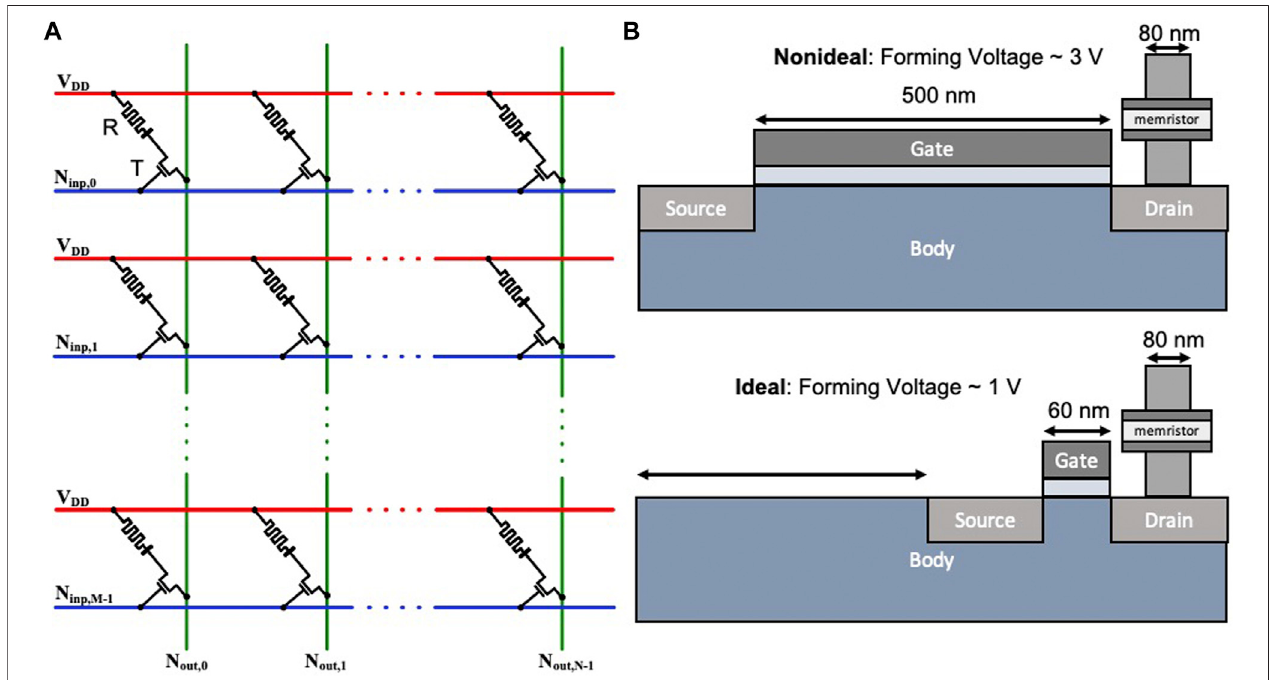
FIGURE 1 | (A) A M × N crossbar array of one-transistor, one-memristor (1T1R) devices for neuromorphic applications. (B) Illustration of the size of transistors needed for memristors having high and low forming voltages.